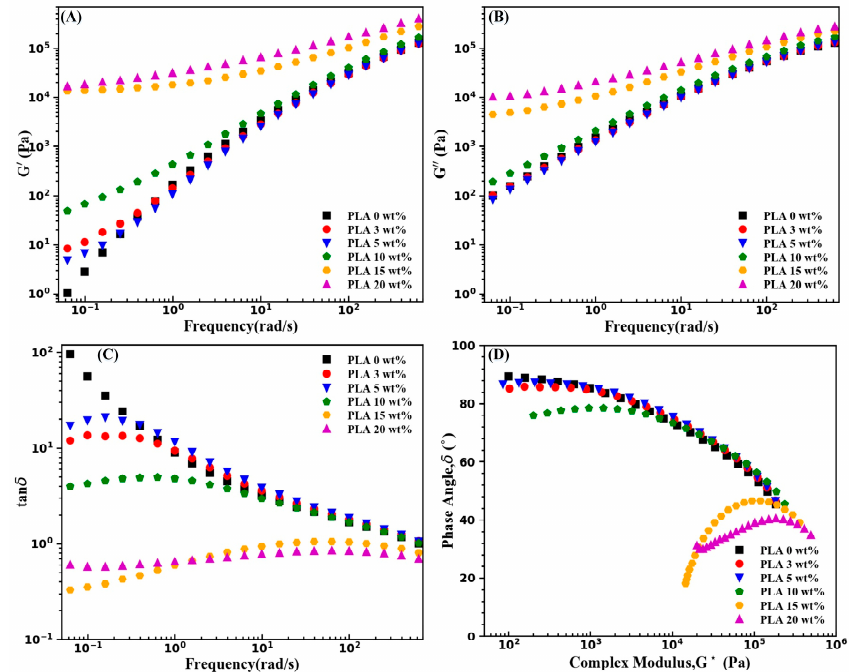
Figure 5. Rheological behavior of the cold-drawn PBS/PLA composites at 130 °C; ( A ) Frequency dependence of G'( ω ); ( B ) Frequency dependence of G''( ω ); ( C ) Frequency dependence of tan δ ; ( D ) Van Gurp plots.